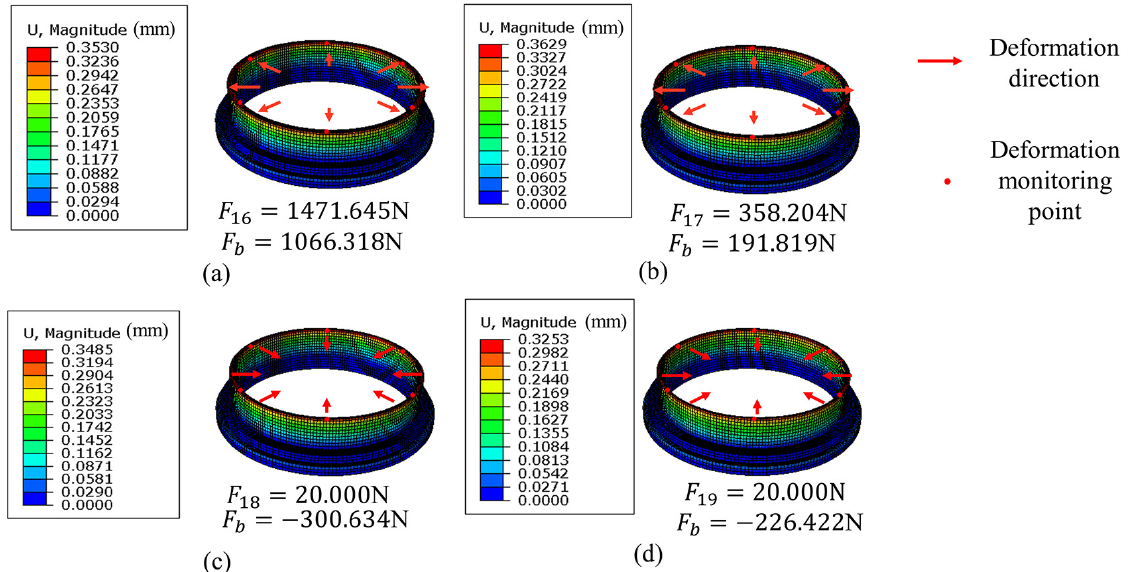
Figure 9. Supporting force and monitoring deformation force at some machining steps. ( a ) Supporting force and monitoring deformation force at the 16th machining step; ( b ) Supporting force and monitoring deformation force at the 17th machining step; ( c ) Supporting force and monitoring deformation force at the 18th machining step; ( d ) Supporting force and monitoring deformation force at the 19th machining step.